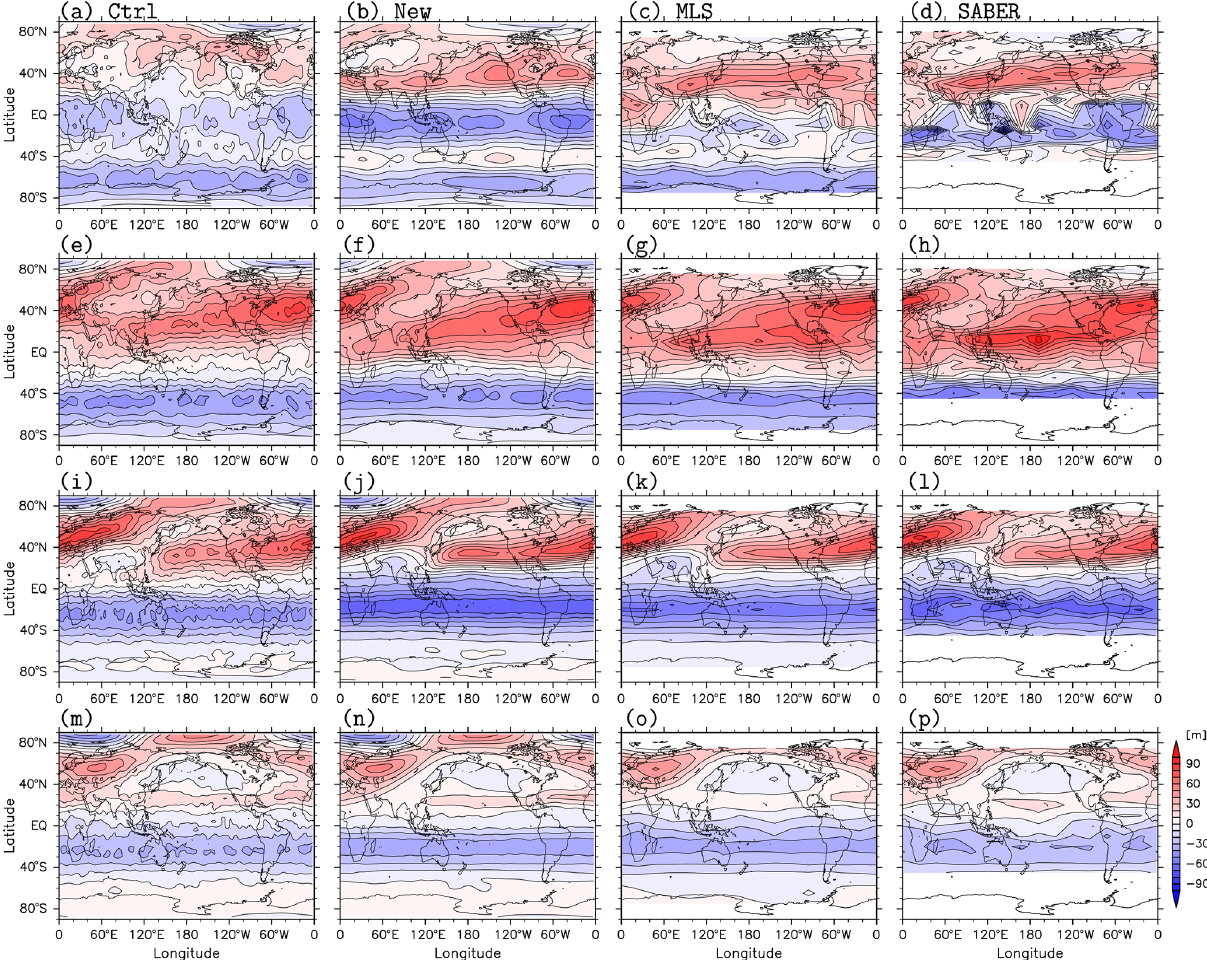
Figure 6. The longitude–latitude sections of zonal wind from the analyses and zonal gradient wind from the satellite observations, which are averaged for the time period of 10–20 February 2017 at 0.01hPa (a–d) , 0.1hPa (e–h) , 1hPa (i–l) , and 10hPa (m–p) . The results in panels (a) , (e) , (i) , and (m) are from the Ctrl (KSMW20) analysis, (b) , (f) , (j) , and (n) are from the new analysis (Expt. IV), (c) , (g) , (k) , and (o) are from the MLS observations, and (d) , (h) , (l) , and (p) are from the SABER observations. The gradient winds from the satellite observations (two right columns) at 10 ◦ S–10 ◦ N are linearly interpolated. Contour intervals are 10ms − 1